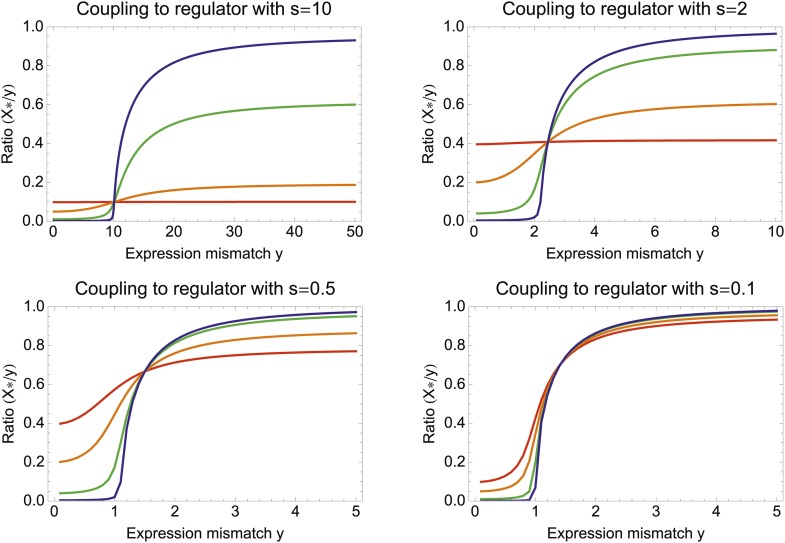
The ratio X*/Y between optimal coupling X* and expression mismatch Y as a function of Y, for different values of the regulator's signal-to-noise ratio S and the correlation between regulator and environment R.Each panel corresponds to a different signal-to-noise ratio S, from a high signal regulator in the top left to a noisy regulator at the bottom right. In each panel, the different colored lines correspond to different correlations R, that is, R = 0.01 (blue), R = 0.1 (green), R = 0.5 (orange), and R = 0.99 (red).